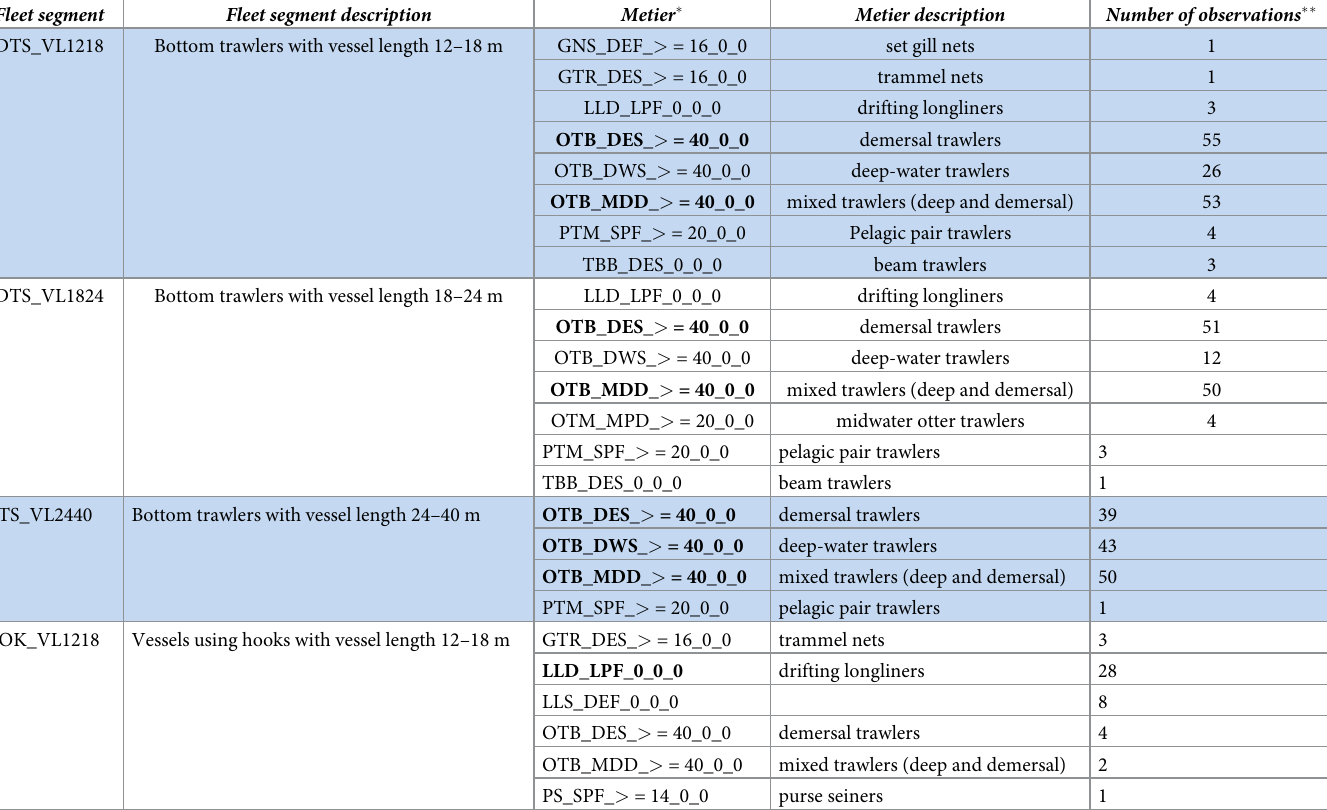
Table 1. Monitored Italian vessels by fleet segment and prevalent me´tier. In bold are the me´tiers representing 80% of the observations in the fleet segment (the 95% only for DTS_VL2440).